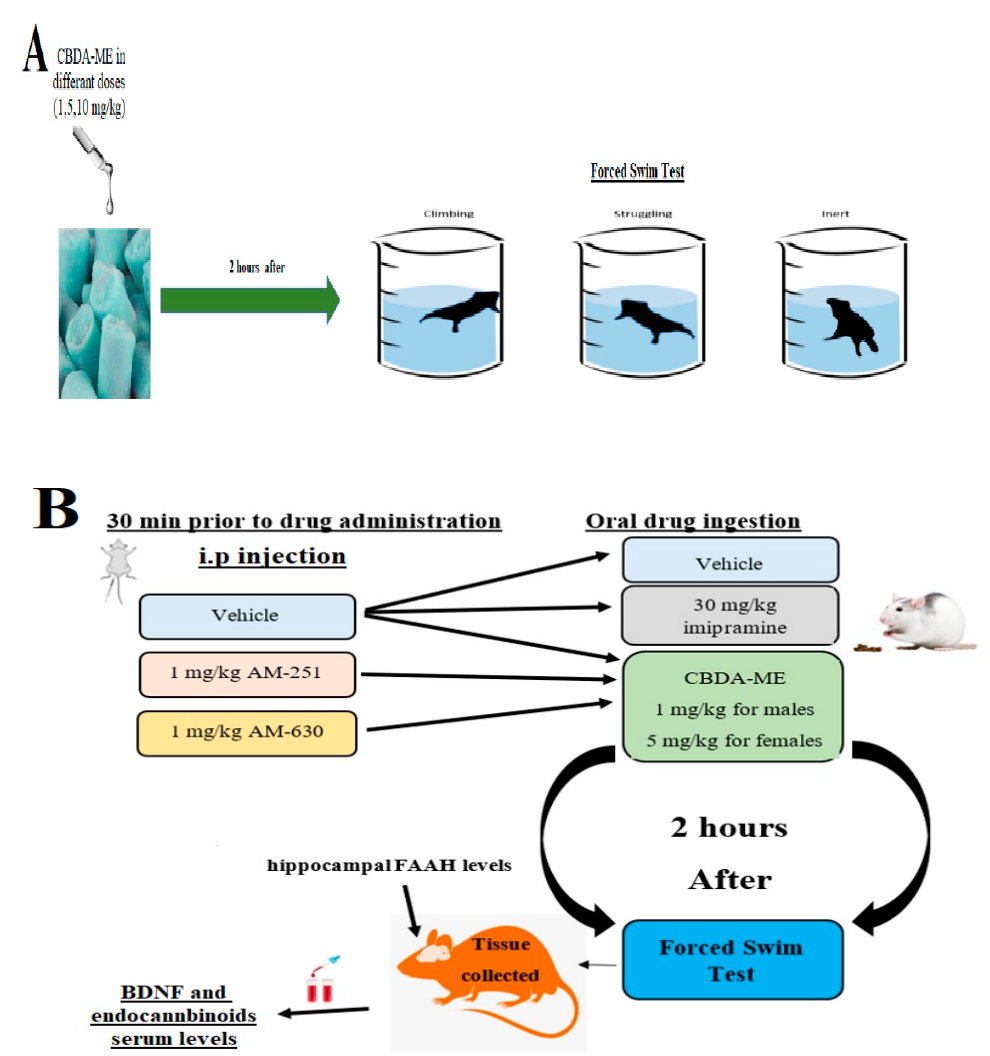
Figure 3. ( A ) Graphic description of the experimental procedure—Experiment 1. ( B ) Graphic description of the experimental procedure—Experiment 2.